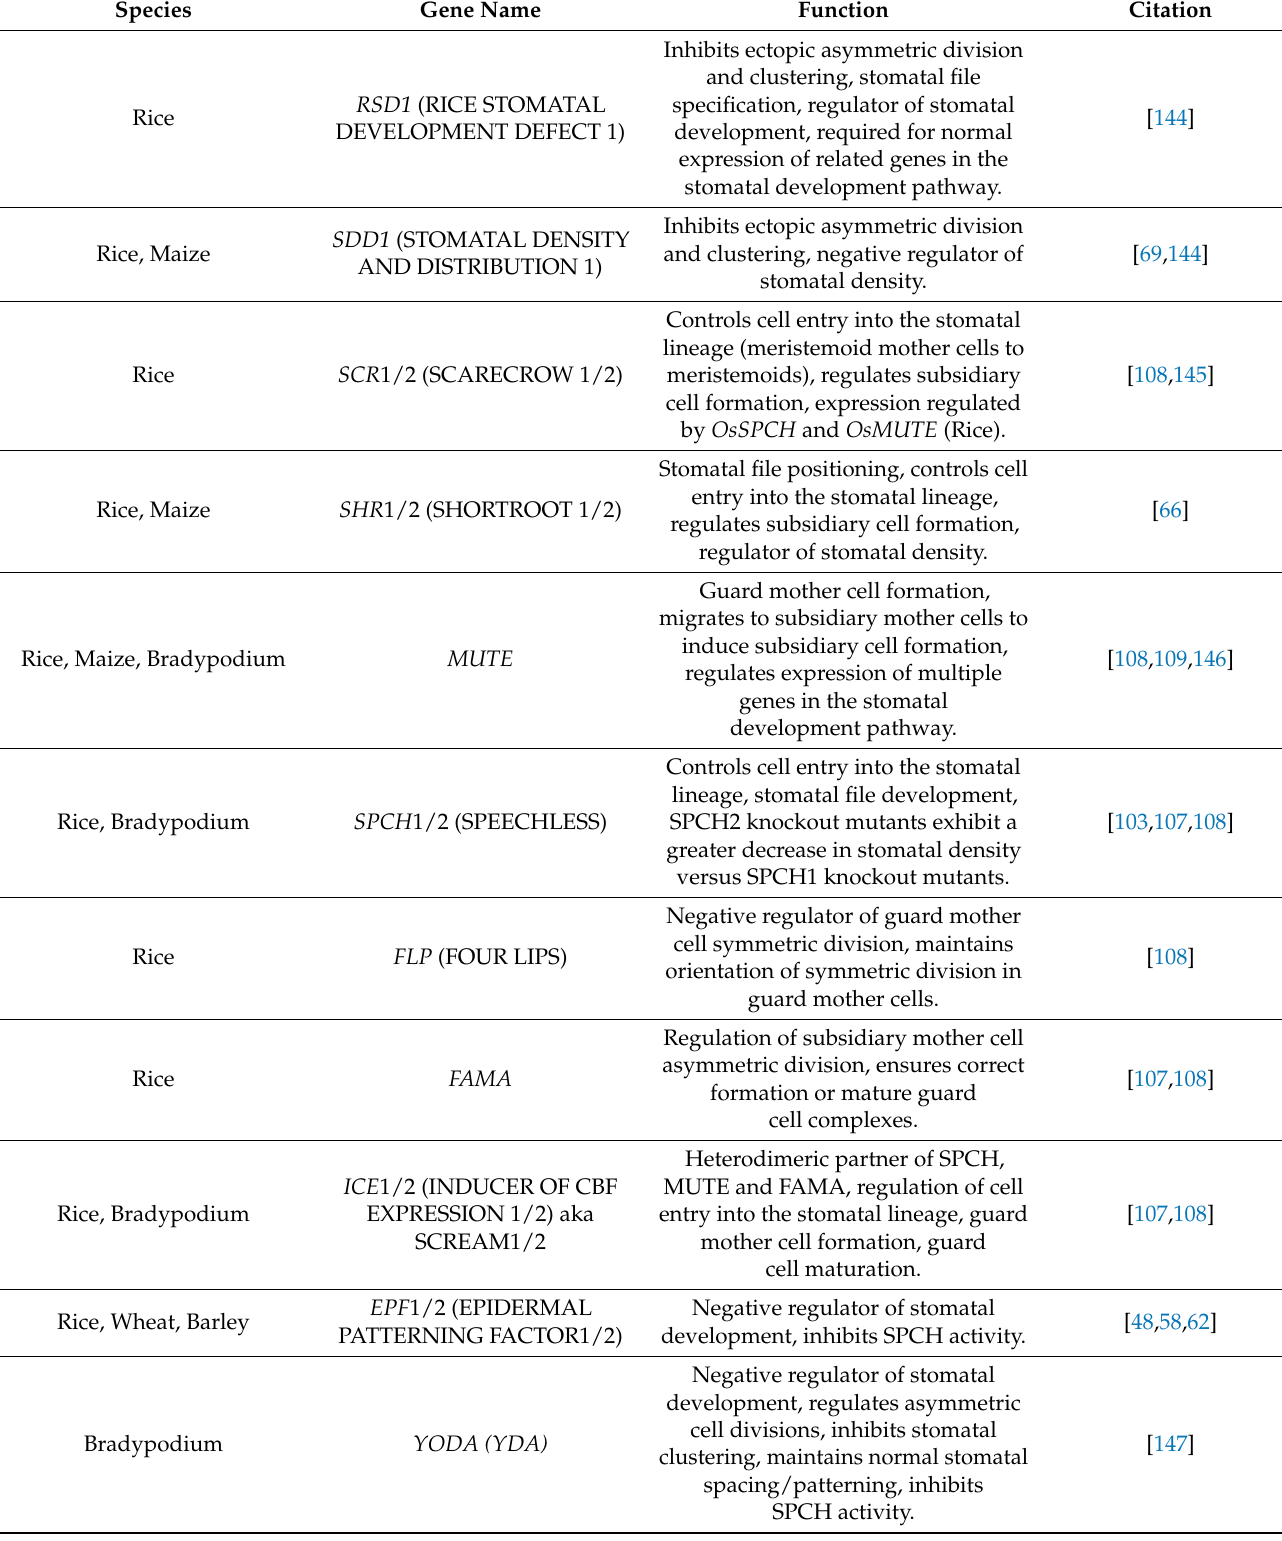
Table 2. List of predominant genes experimentally verified to regulate stomatal development in various cereal crops.